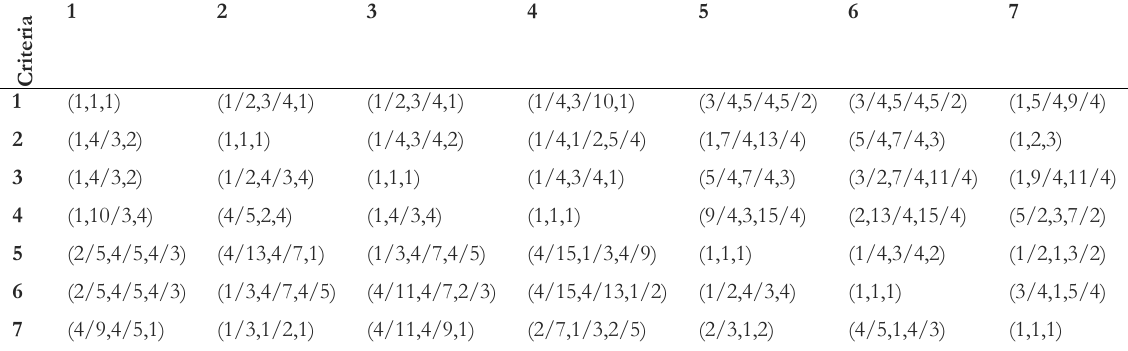
Table 3. The integrated matrix of the pairwise comparisons.